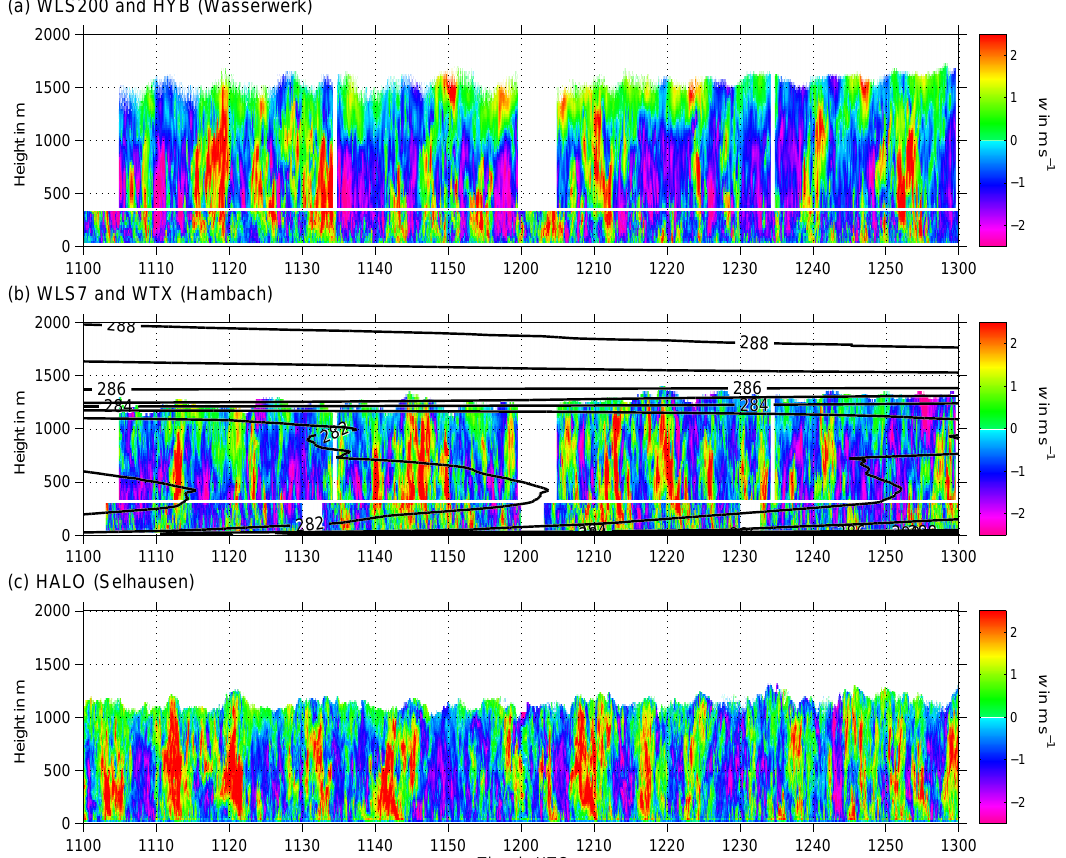
Figure 3. Vertical velocity as observed by Doppler lidars at three different locations on 20 April 2013 (11:00–13:00UTC) with isolines of potential temperature (in K) in (b) as derived from radiosoundings.